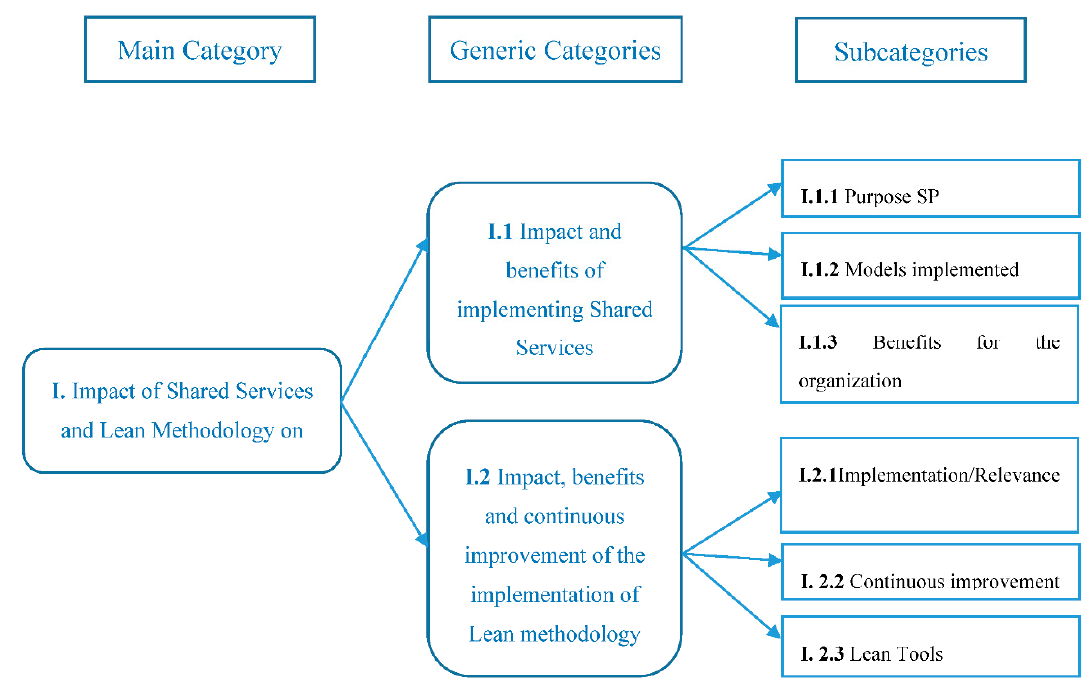
Figure 1. Characterization and coding of the interviews.